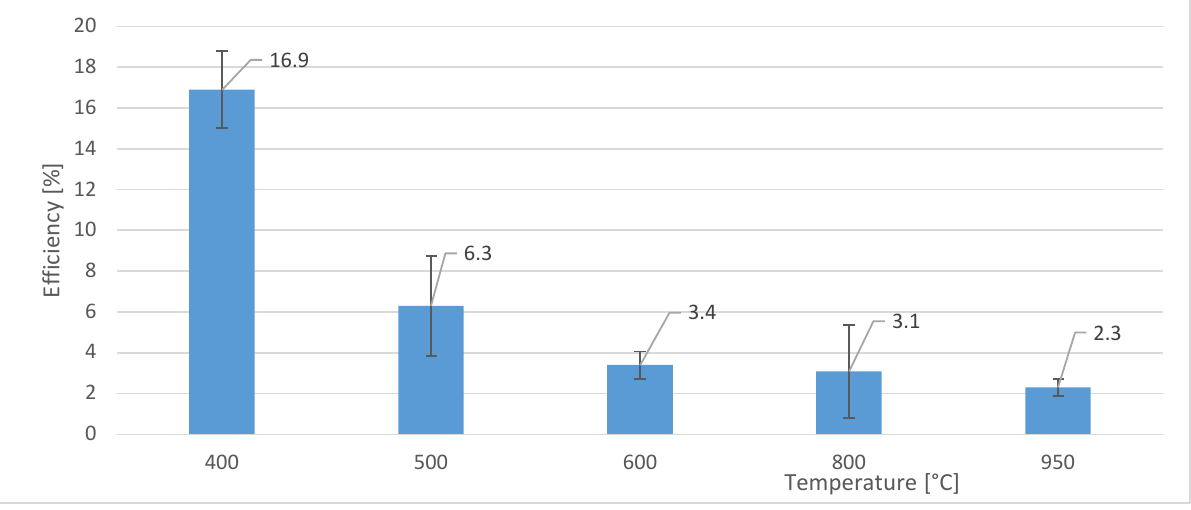
Figure 5. Efficiency % (T) of the formulation F50.2 containing Mg(OH) 2. Standard deviation ranges are reported.